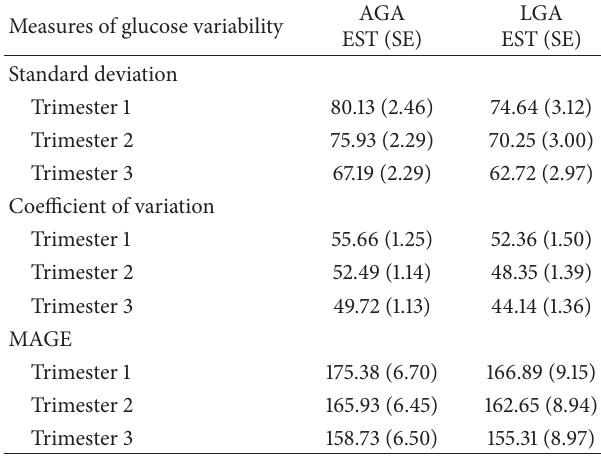
Table 1: Measure of glucose variabilities compared between LGA and AGA babies across trimesters ∗